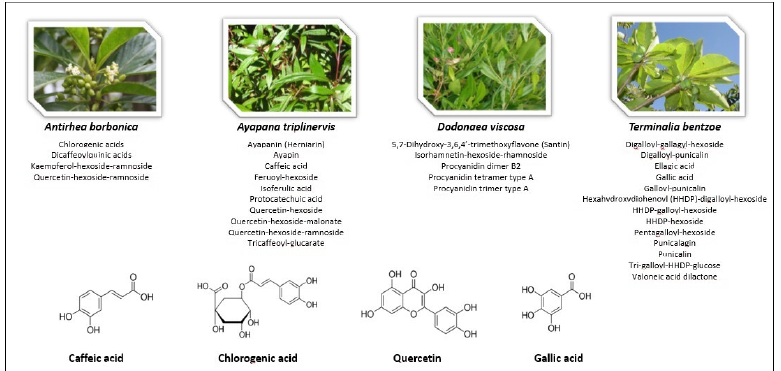
Figure 1. Polyphenol-rich medicinal plant extracts and pure polyphenols tested. The polyphenols present in the extracts obtained from A. borbonica , A. triplinervis , D. viscosa and T. bentzoe medicinal plants were previously identified [21]. Caffeic acid, chlorogenic acid and quercetin derivatives were detected as main polyphenols present in A. borbonica , A. triplinervis and D. viscosa plants, while gallic acid derivatives were detected in T. bentzoe plant. Consistently, pure quercetin, caffeic, chlorogenic and gallic acids were used as control polyphenols in the experiments.